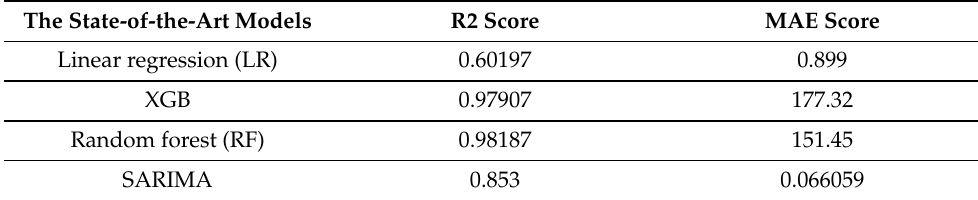
Table 6. A comparison with the state-of-the-art